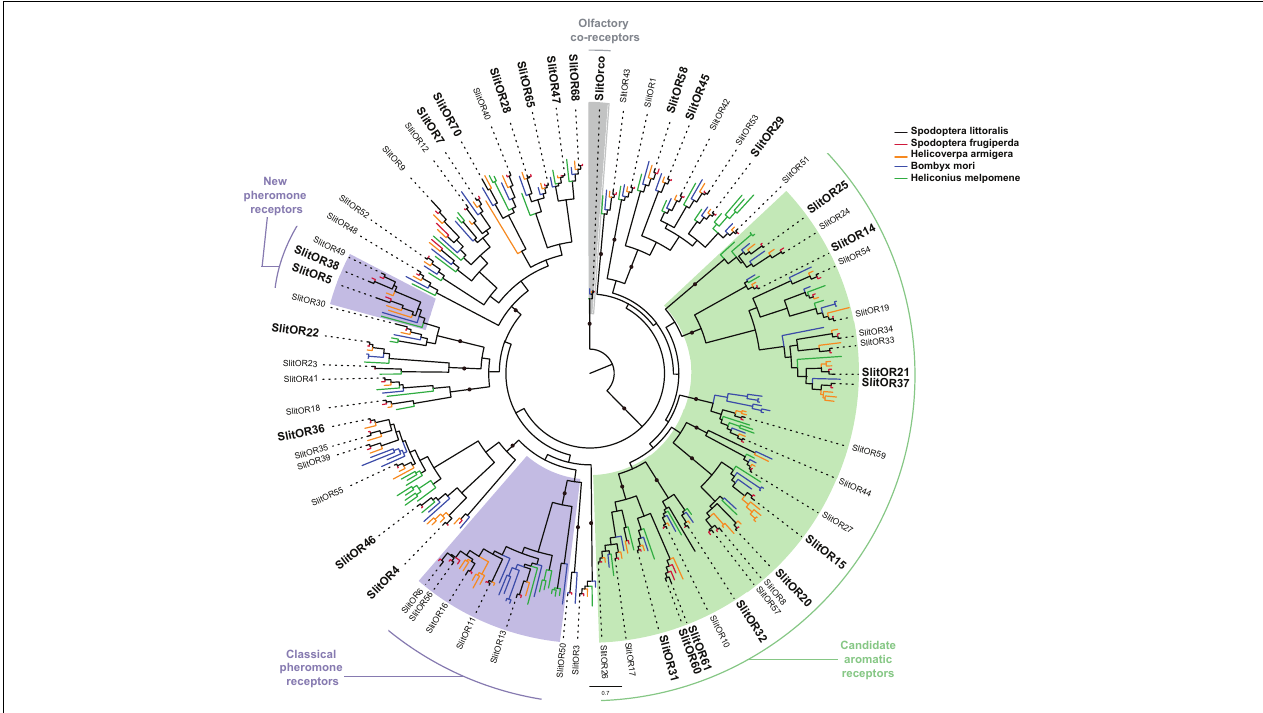
FIGURE 3 | Phylogenetic position of S. littoralis odorant receptors (SlitORX, black). The phylogeny was built using OR repertoires of the moths S. frugiperda (red), H. armigera (yellow) and B. mori (blue), and the butterfly H. melpomene (green). SlitGRs found in the present transcriptome are written in bold. Clades of candidate receptors for pheromones and aromatics are shown with purple and green color shades, respectively. The odorant receptor coreceptor (Orco) clade is shaded in gray and was used as an outgroup. Clades supported by an aLRT value over 0.9 are indicated by a black